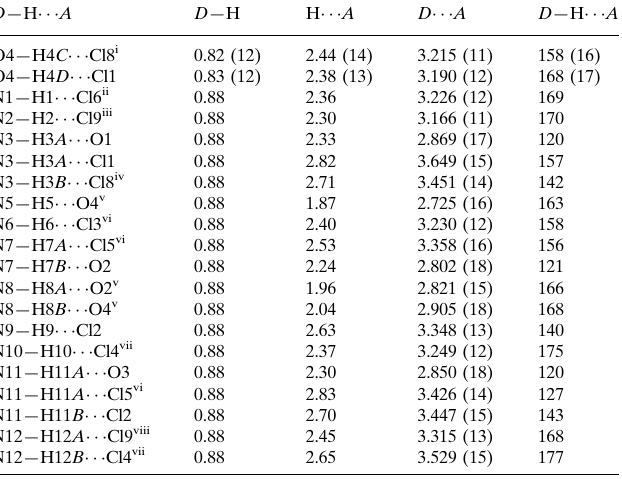
Hydrogen-bond geometry (A˚ , (cid:3)